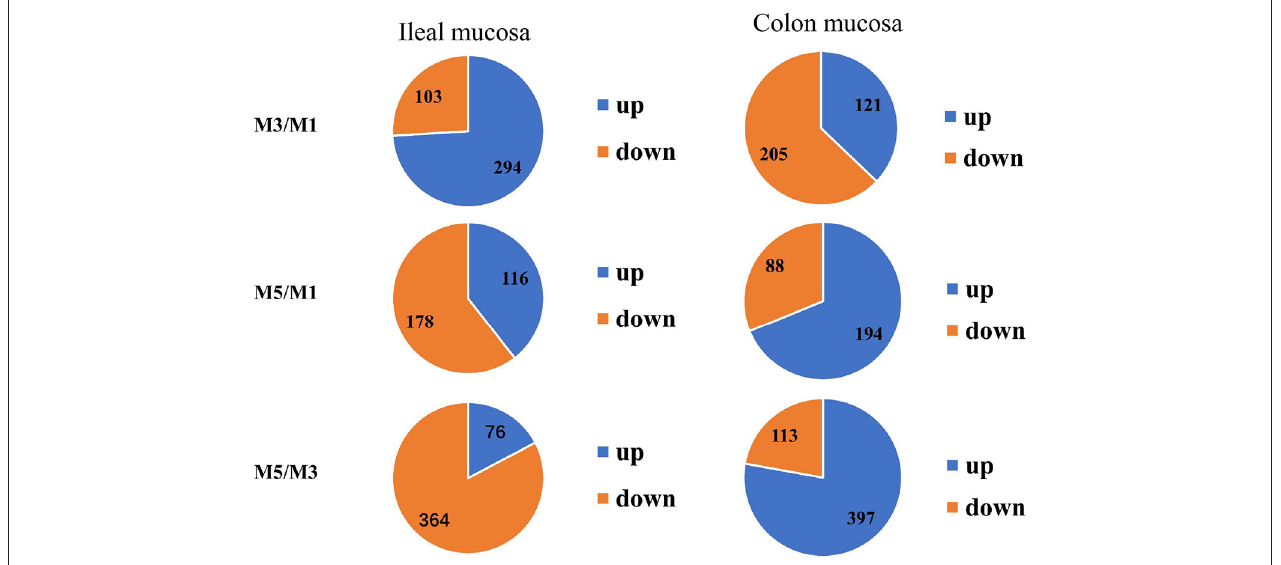
FIGURE 3 | Numbers of the total differentially expressed genes as well as the up- and down-regulated genes in the ileum mucosa and colon mucosa of pigs among the one meal feeding daily (M1), three meals feeding daily (M3), and five meals feeding daily (M5)